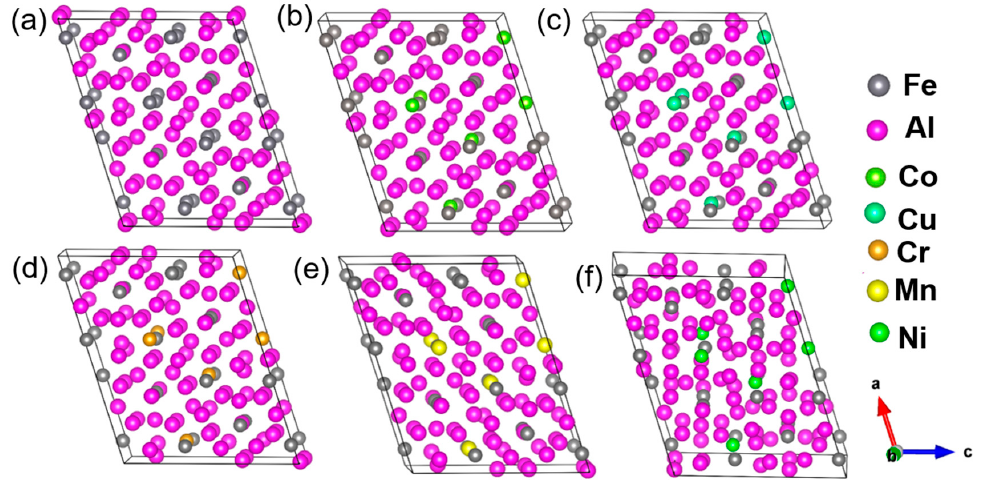
Figure 2. Crystal structure projection of Al 13 (Fe,M) 4 phases with different alloying elements doping. ( a ) θ -Al 13 Fe 4 , ( b ) Al 13 (Fe,Co) 4 , ( c ) Al 13 (Fe,Cu) 4 , ( d ) Al 13 (Fe,Cr) 4 , ( e ) Al 13 (Fe,Mn) 4 , ( f ) Al 13 (Fe,Ni) 4 Table 2. Structural information, lattice parameters (Å), cell volume (Å 3 ), and formation enthalpy (E f ) (at 0 K) for M occupying Fe sites in the θ -Al 13 Fe 4 phase. Al 13 (Fe,M) 4 Atom Coordinates of M